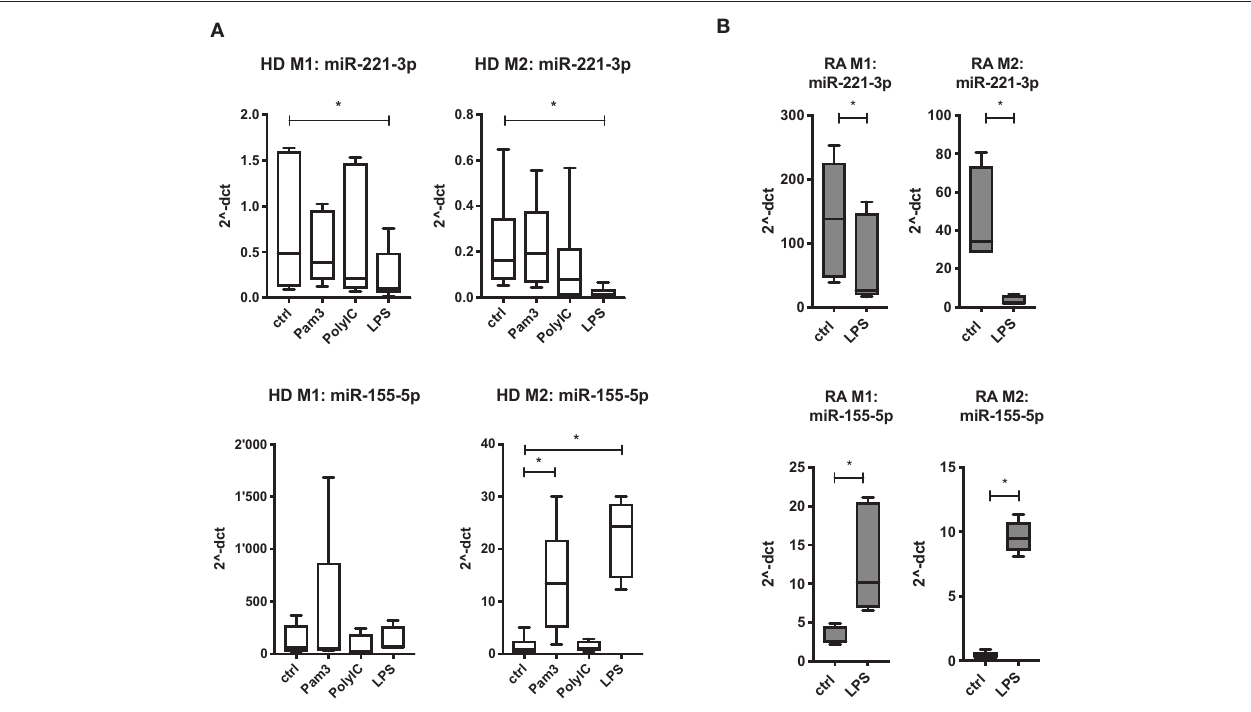
FIGURE 2 | Regulation of miR 221-3 p and miR-155-5 p in M1- and M2-macrophages by TLR ligands. Macrophages differentiated from CD14 + cells from (A) HD or (B) RA blood were stimulated with either 300ng/ml Pam3 (TLR2), 10 µ g/ml PolyIC (TLR3) or 100ng/ml LPS (TLR4) for 24h. Changes in miR expression levels were measured by qRT-PCR. Values were normalized to RNU48, miR-103a-3 p, or miR-15b-5 p and presented as 2 − 1 CT by boxplot with min/max whiskers. N = 3–6, * p < 0.05 compared to untreated cells